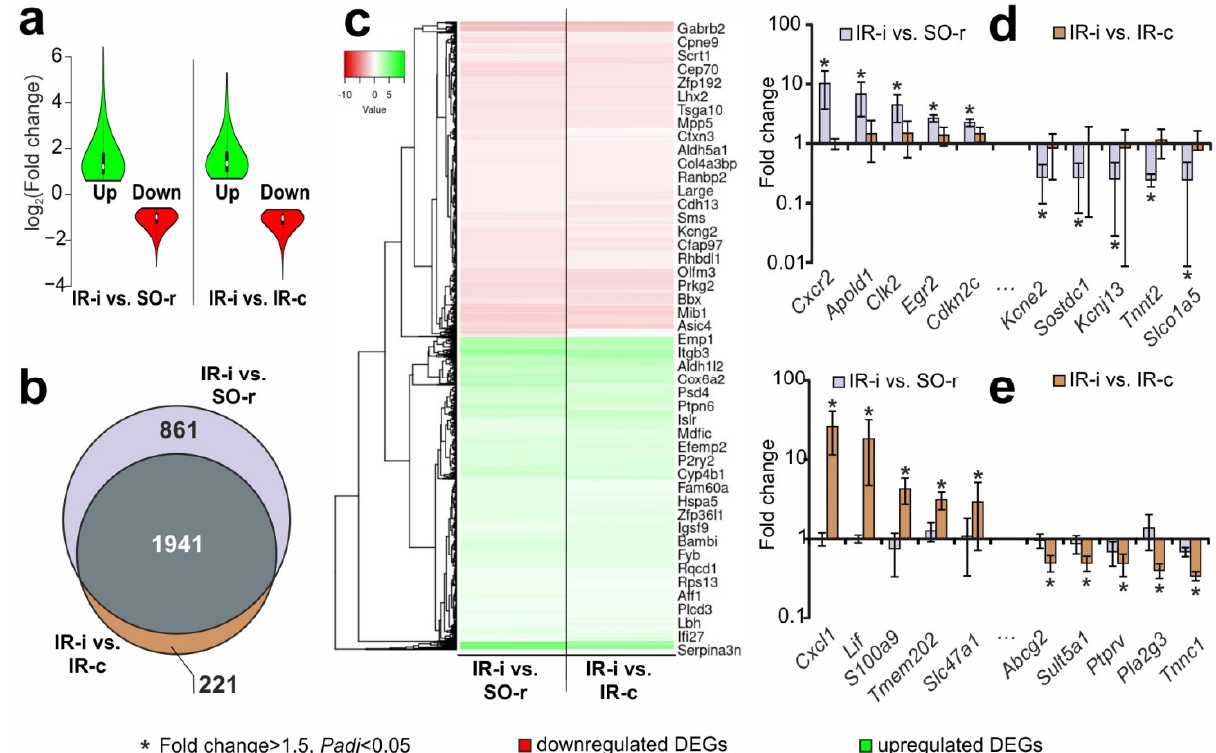
Figure 3. Comparisons of the results of DEGs in the subcortical structures of the IH at 24 h after tMCAO, obtained using CH and SO controls. ( a ) Violin plot comparing the distributions of the intensities of expression changes for DEGs from each pairwise comparison of IR-i vs. SO-r and IR-i vs. IR-c. ( b ) The Venn diagram represents the schematic comparisons of the results obtained using two controls in pairwise comparisons of IR-i vs. SO-r and IR-i vs. IR-c. ( c ) Hierarchical cluster analysis of all DEGs in IR-i vs. SO-r and IR-i vs. IR-c. Each column represents a comparison group, and each row represents a DEG. The green strips indicate high relative expression levels, and the red strips indicate low relative expression levels; n = 3 per group. ( d ) The top 10 genes that exhibited the greatest fold change in expression in IR-i vs. SO-r were non-DEGs that exhibited a fold change <1.50 in IR-i vs. IR-c. ( e ) The top 10 genes in IR-i vs. IR-c that were non-DEGs with a fold change <1.50 in IR-i vs. SO-r. The data are presented as the mean ± SE. Genes with a fold change >1.50 and Padj < 0.05 in the comparison group are marked with an asterisk